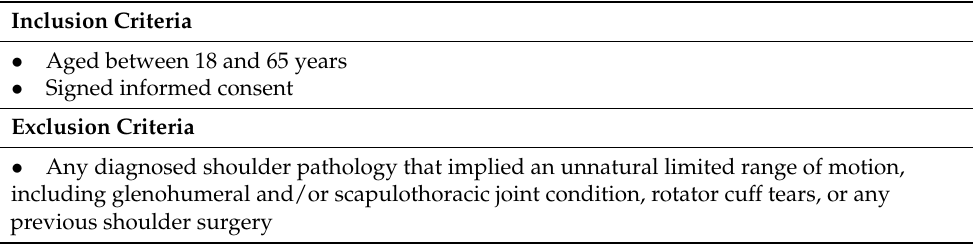
Table 1. Inclusion and exclusion criteria for the control group.